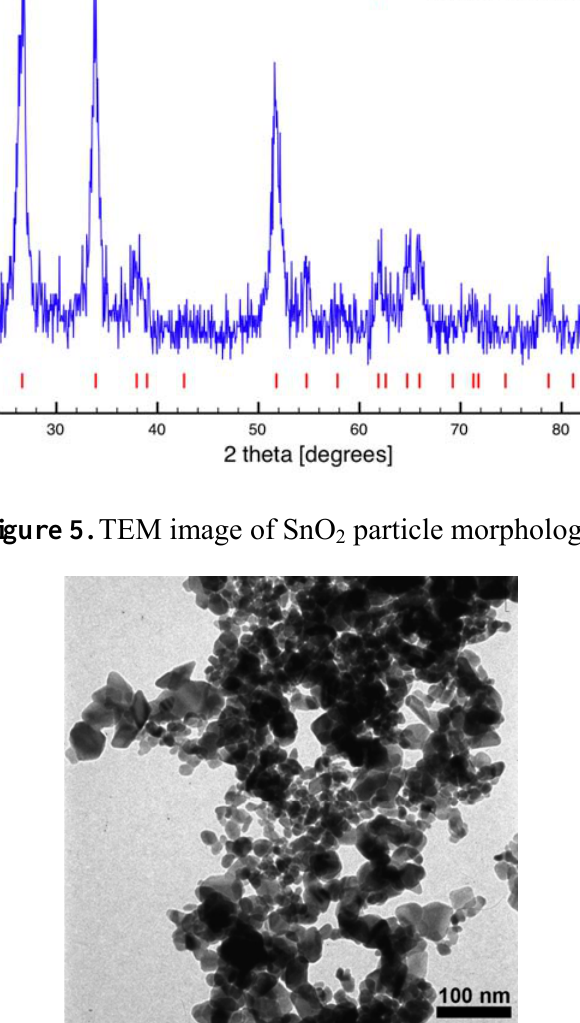
Figure 4. X-ray diffraction analysis of combustion generated tin dioxide nanoparticles. The vertical bars represent the reference peaks for the cassiterite phase of tin dioxide.